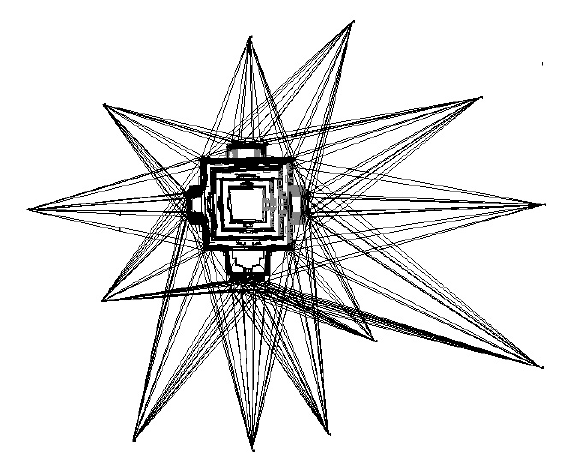
Figure 3. Network of oriented panorama (Hoa Lai